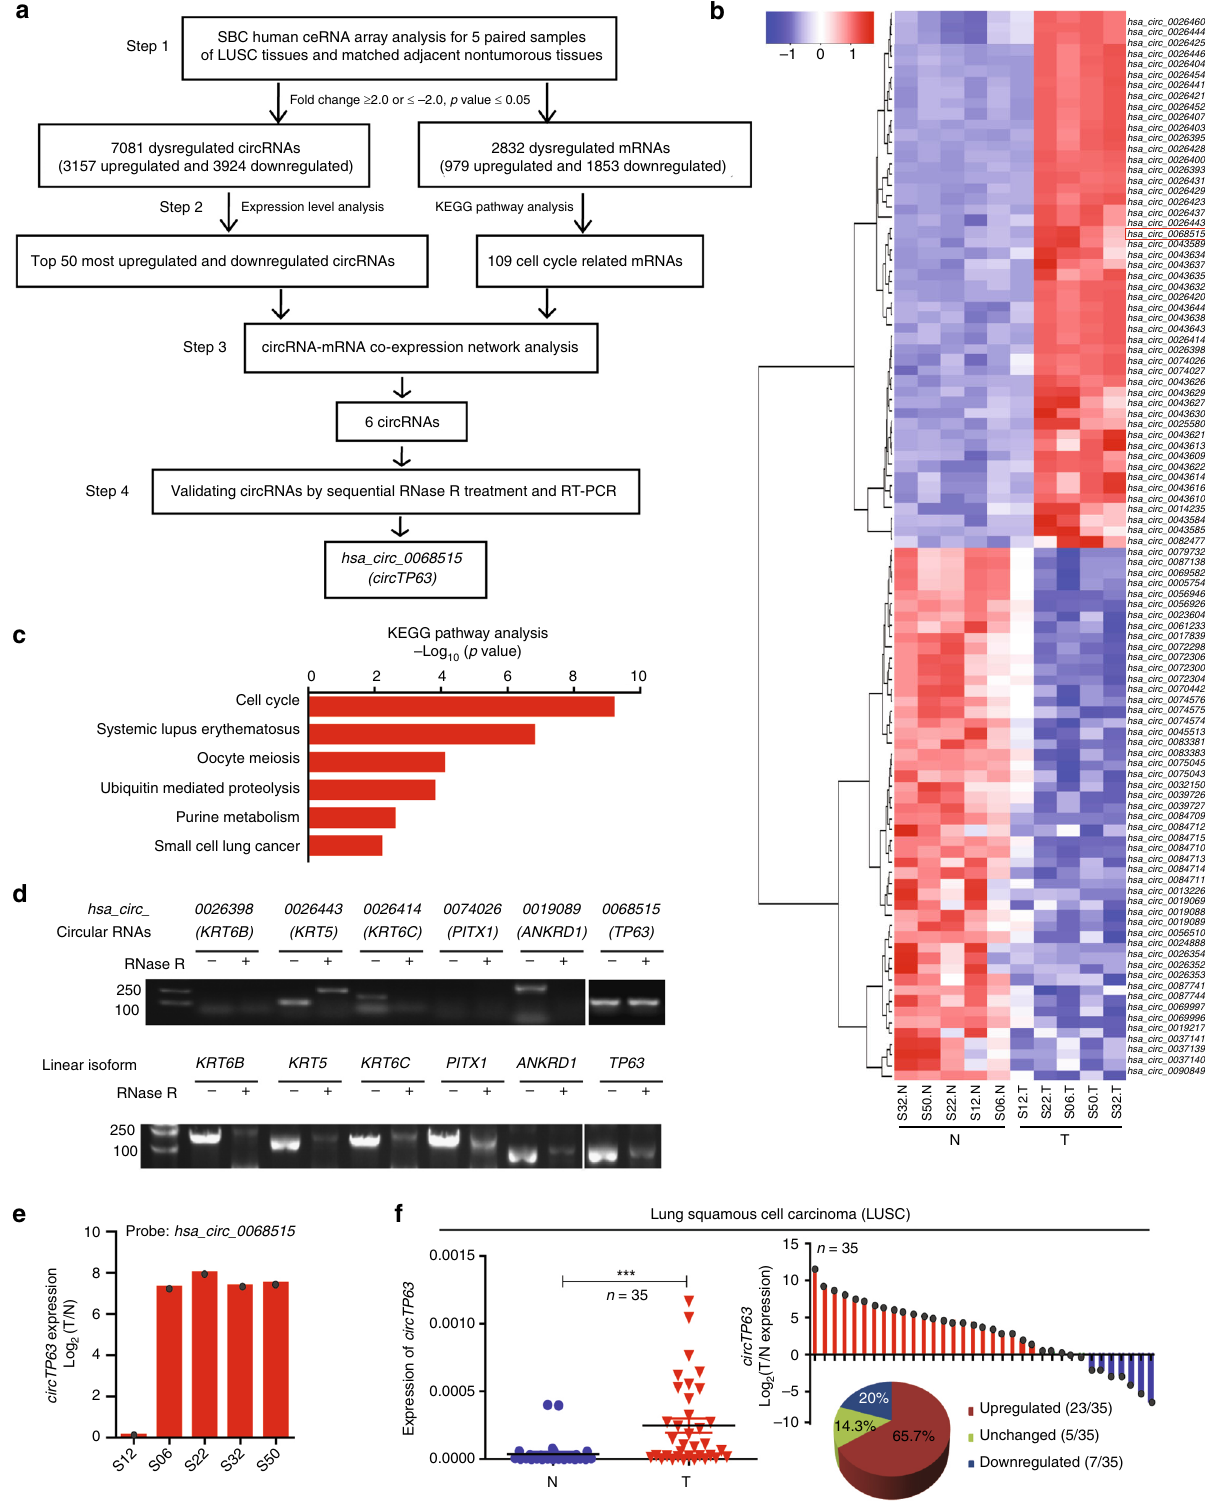
analysis for reverse-transcribed RNA (cDNA) and genomic DNA (gDNA) showed that divergent primers could amplify products from cDNA but not from gDNA (Fig. 2b). Northern blot analysis was performed to con fi rm that circTP63 could be observed at 295nt with a probe targeted the back-spliced junction (Fig. 2c). with Actinomycin D, an inhibitor of transcription, revealed that NATURE COMMUNICATIONS| (2019) 10:3200